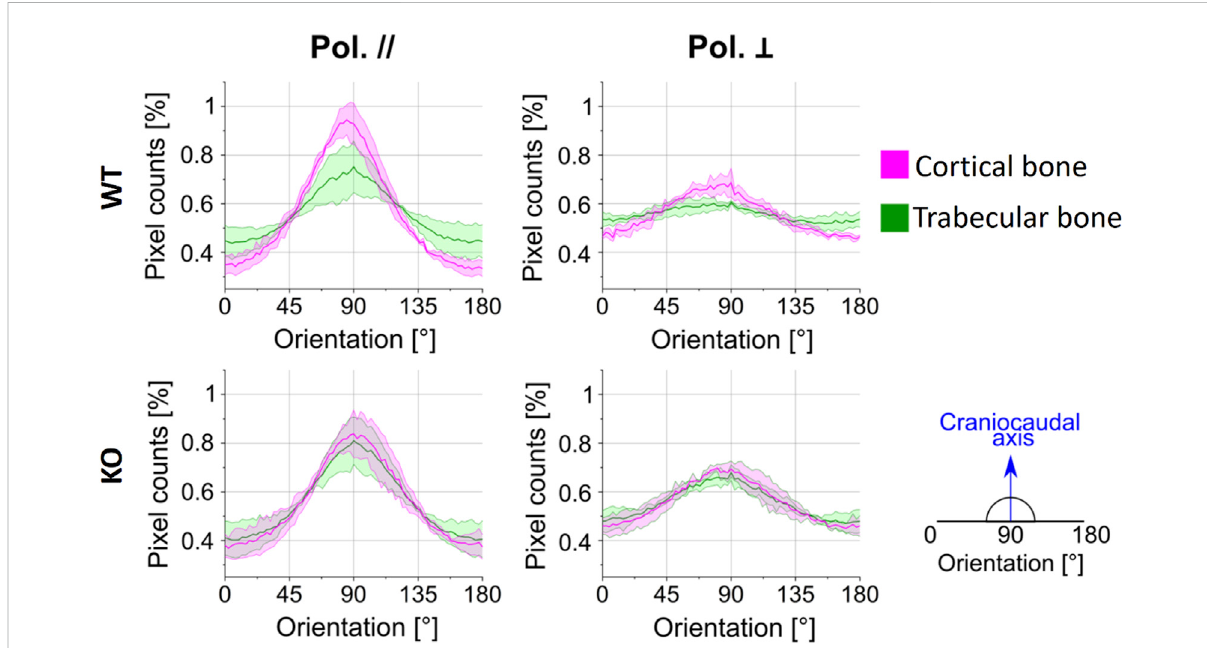
FIGURE 6 Collagen fi ber orientation results: the normalized pixel counts are reported in percentage as a function of the fi ber orientation in the 0 ° – 180 ° range, for any combination of polarization ’ s orientation (parallel and perpendicular), sample model (WT and KO; n = 3 per genotype) and bone area (cortical and trabecular bone). The solid line represents the average value, and the shaded area the standard deviation.